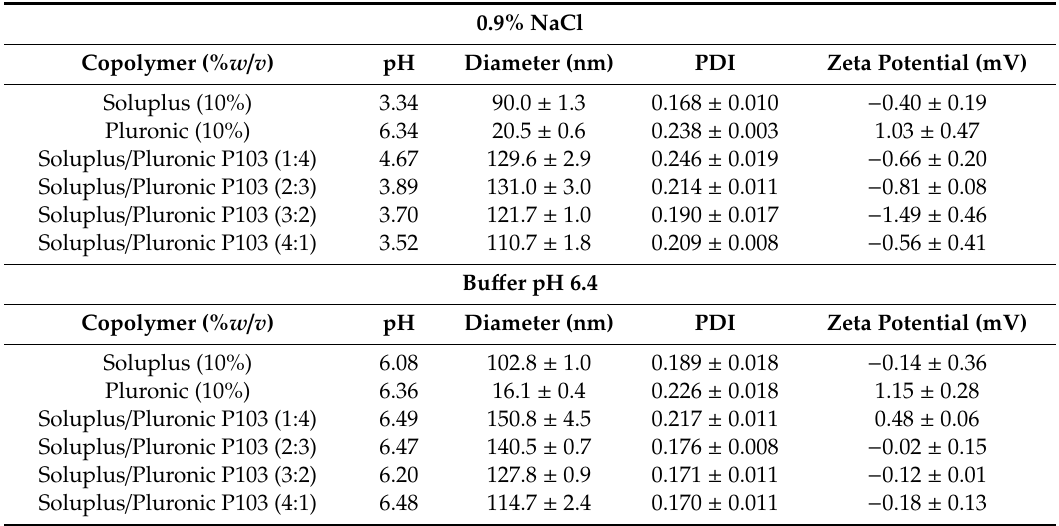
Table 1. The pH, size, and zeta potential of unloaded micelles of Soluplus and Pluronic P103 and their mixtures prepared at various volume ratios in 0.9% NaCl and pH 6.4 bu ff er.